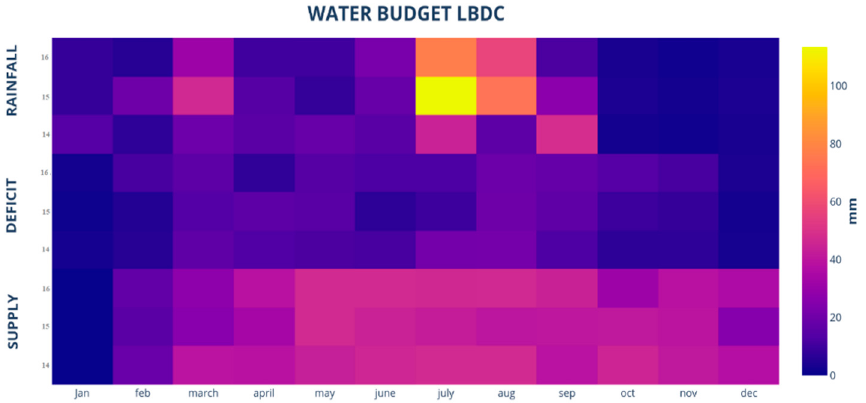
Figure 14. Crop water balance heat map for years 2014, 2015, and 2016 (developed in R-Studio).